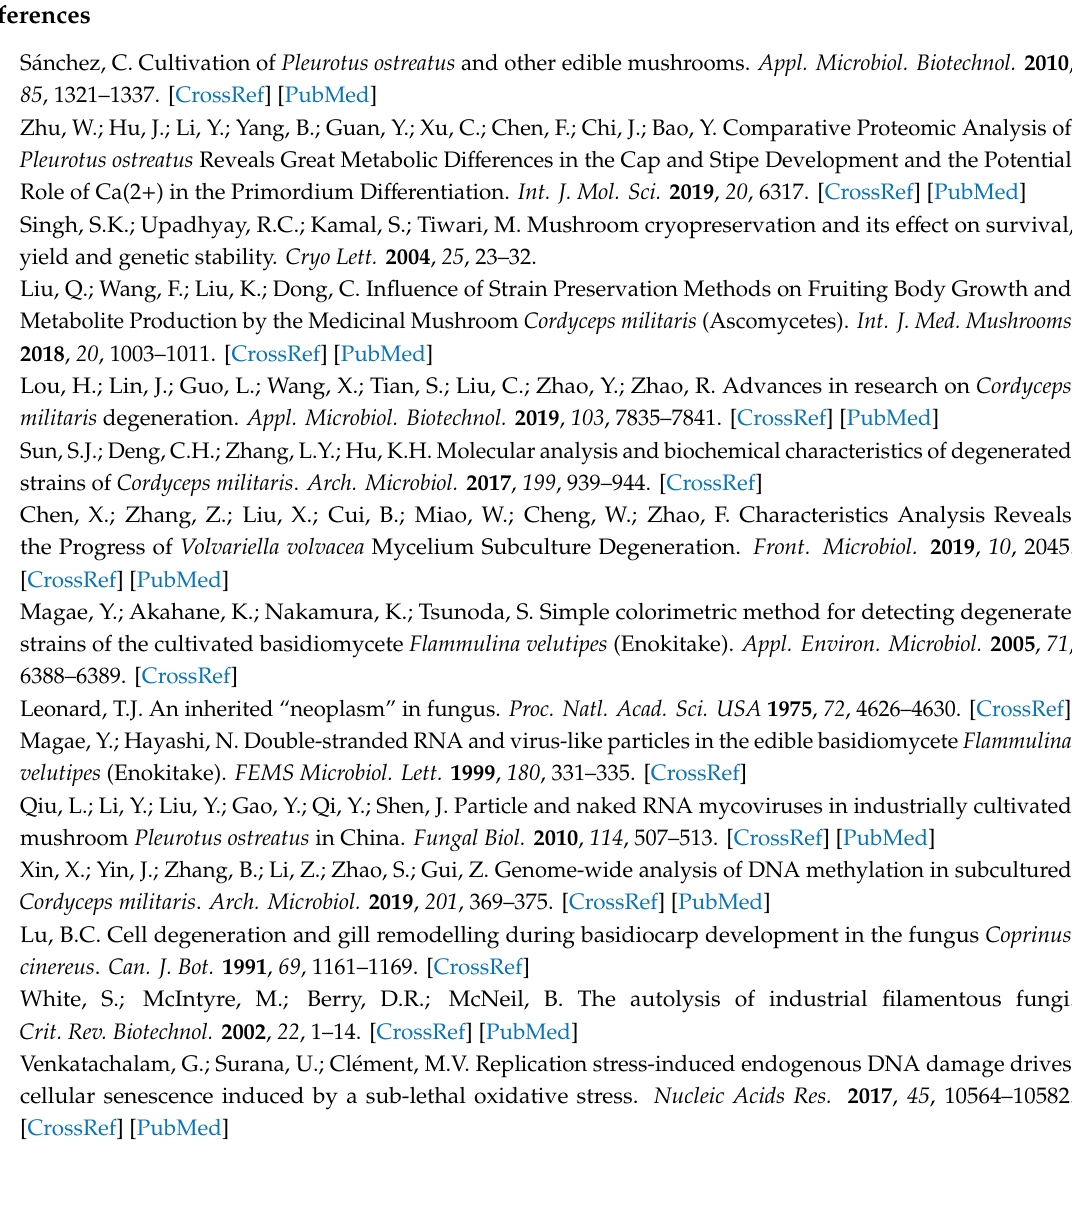
Supplementary Materials: The following are available online. Figure S1: Overview of the proteomic result, Table S1: All identified proteins and DEPs, Table S2: GO enrichment of the up-regulated DEPs, Table S3: GO enrichment of the down-regulated